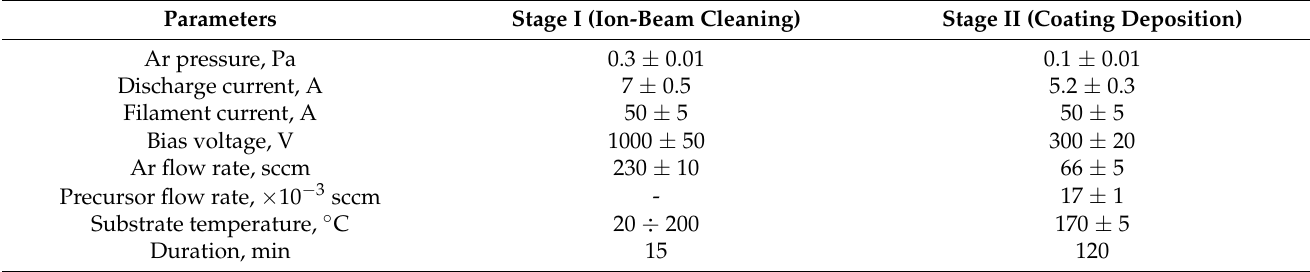
Figure 11. Stages of sample preparation and a-C:H:SiO x coating deposition. Table 1. PACVD process parameters.